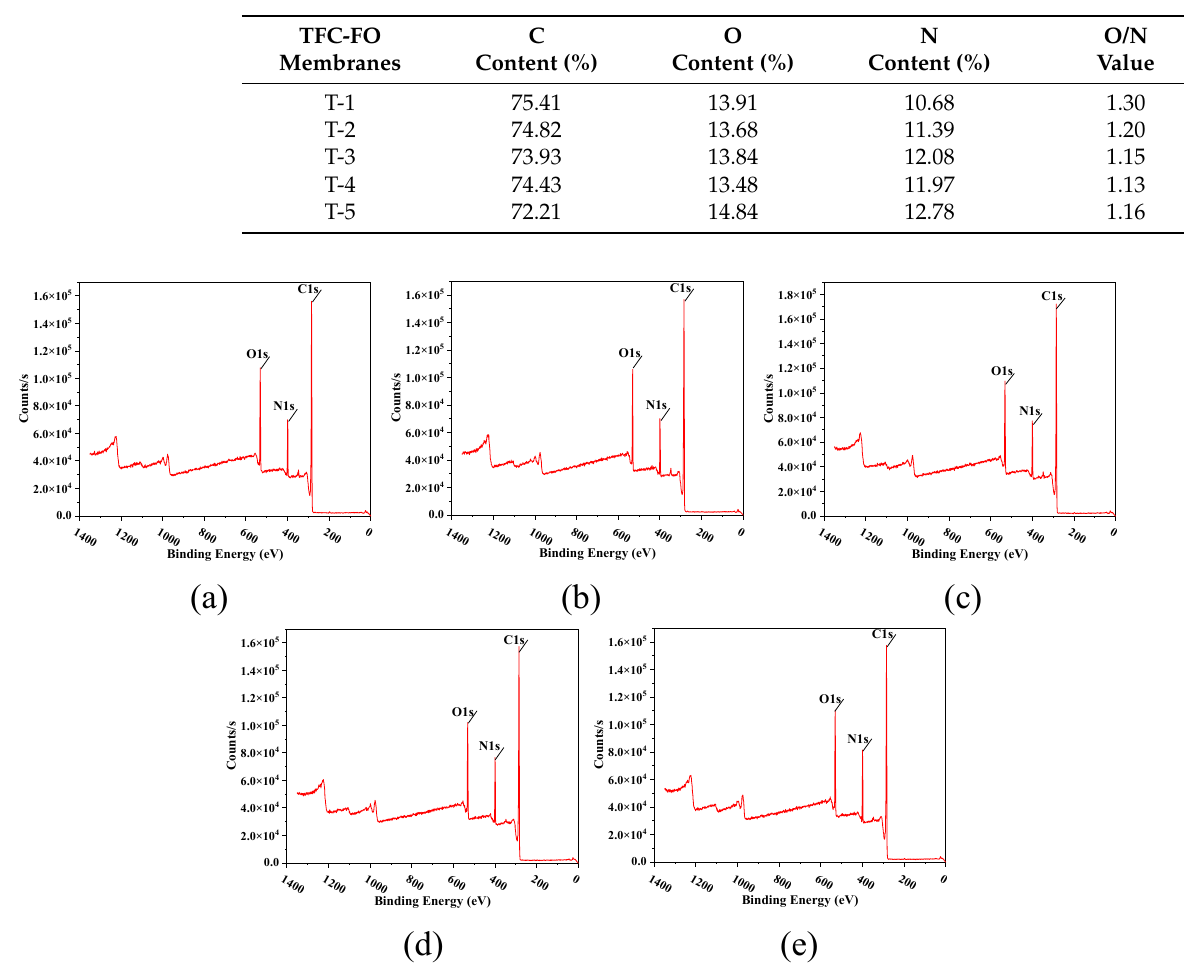
Table 2. The elements composition and O/N ratios of the TFC-FO membranes with different amounts of MXene nano-sheets.